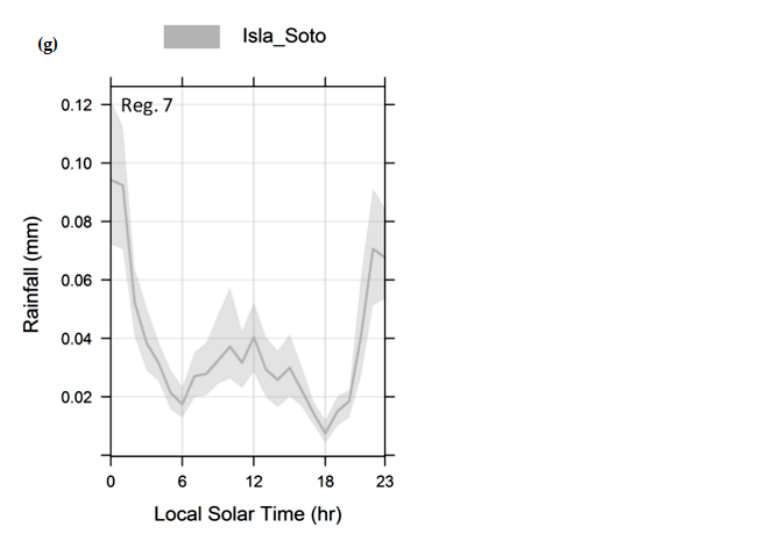
Figure 9. Mean diurnal cycle of summer precipitation at seven selected regions. CMORPH (thin gray solid line indicates 2002–2013). The abscissa represents the diurnal cycle phase (LST), and the ordinate represents the region’s average precipitation rate (units: mm d − 1 ). ( a ) Region Puno; ( b ) Region Santa Rosa; ( c ) Region Crucero; ( d ) Region Cabanillas; ( e ) Region Isla Suana; ( f ) Region Arapa; ( g ) Region Isla Soto.